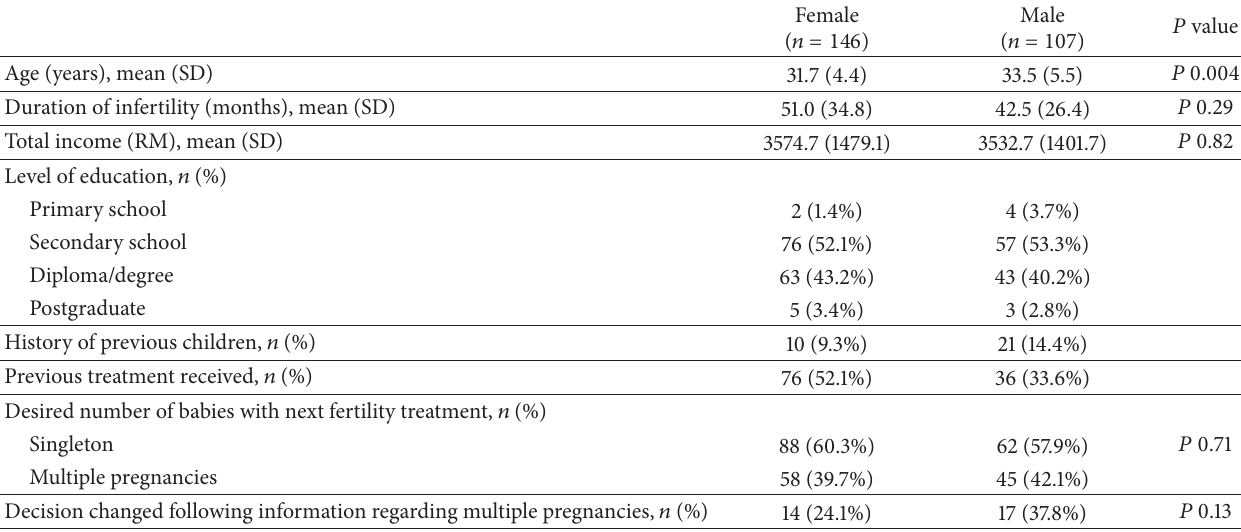
Table 1: Demographic data and baseline characteristics of respondents.